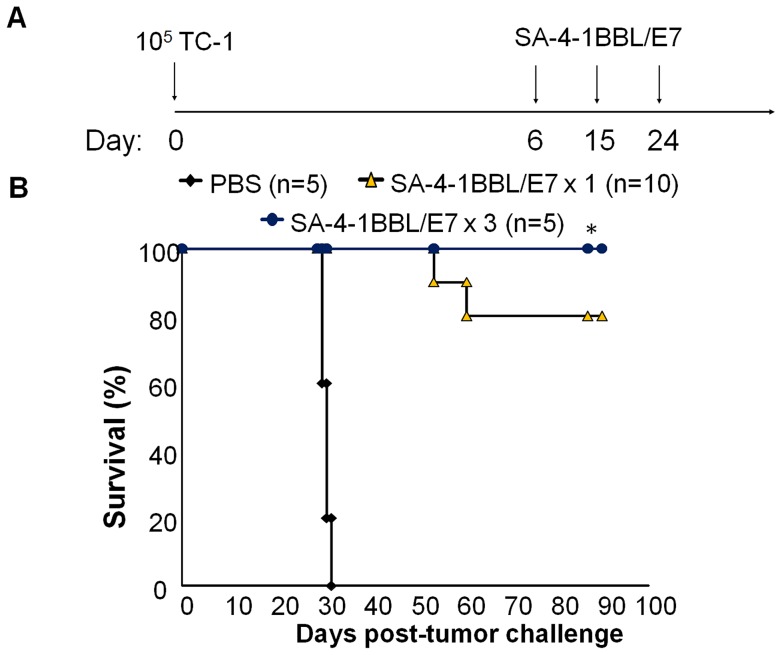
The therapeutic efficacy of SA-4-1BBL/E7 vaccine is improved by multiple vaccinations in the TC-1 cervical cancer model.(A) Schematic depiction of the experimental procedure. (B) C57BL/6 mice were immunized s.c. with the optimized SA-4-1BBL/E7 (25 µg/50 µg) vaccine formulation on day 6 post-challenge with 1×105 live TC-1 tumor cells. A group of mice received two more vaccinations administered on days 15 and 24 post-tumor challenge. Mice vaccinated with PBS were used as controls. P<0.05 vs. PBS group, but not SA-4-1BBL/E7 x 1 group.